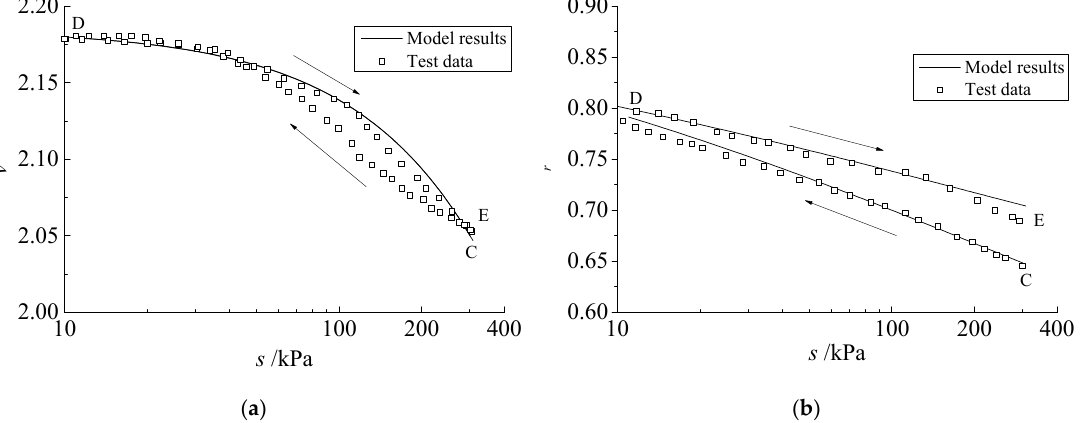
Figure 4. Comparison between predicted results and measured test data for Speswhite kaolin during the wetting and drying cycle: ( a ) specific volume; ( b ) degree of saturation.